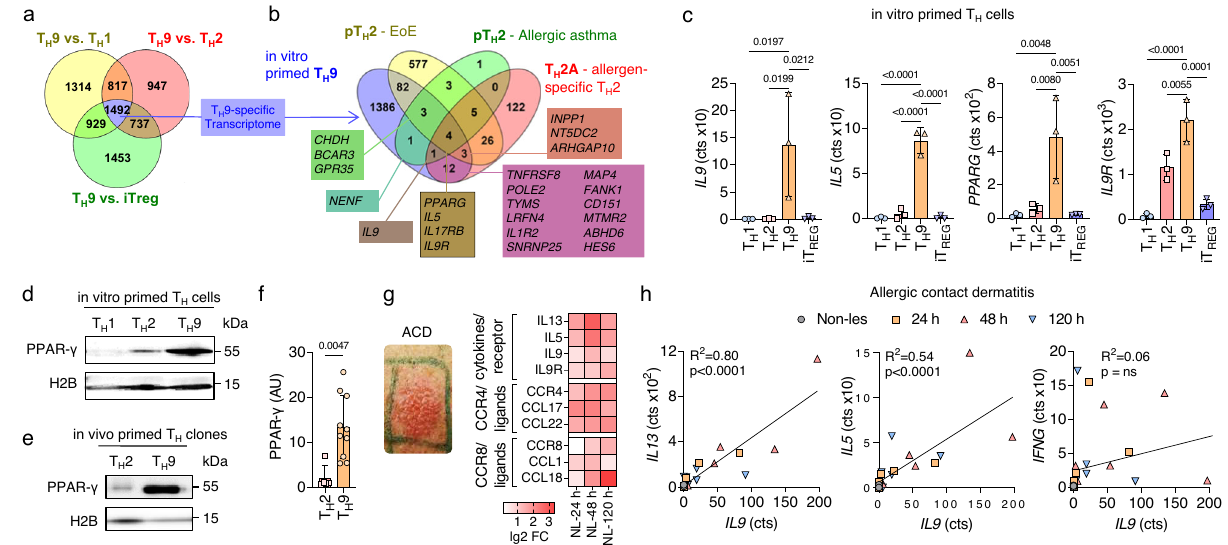
Fig. 1 | In vitro and in vivo primed T H 9 cells display key features ofpathogenic T H 2 cells. a Venn diagram of RNA-seq data from T H cell subsets primed in vitro showing the number of genes signi fi cantly upregulated in T H 9 cells compared to other cell subsets ( p adj <0.05). b Venn diagram of T H 9-speci fi c transcriptome identi fi ed in a and pT H 2-associated genes identi fi ed in eosinophilic esophagitis (EoE) 4 , allergic asthma 5 , and allergen-speci fi c T H 2 cells (T H 2A) 7 . c Expression